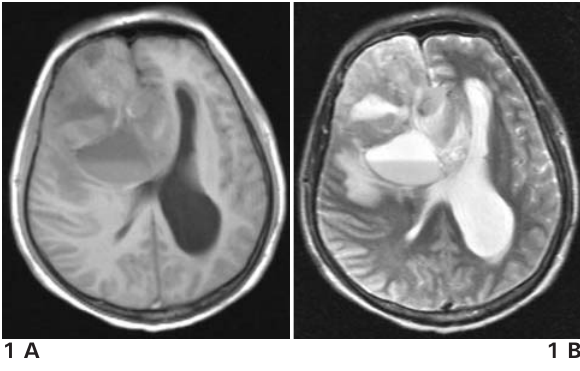
Figure 1. A. T1 weighted image shows a large cystic mass compressing anterior horn of the ipsilateral lateral ventricle causing supratentorial herniation. Figure 1. B. T2-weighted image shows heterogeneous high signal intensity with perilesional edema.